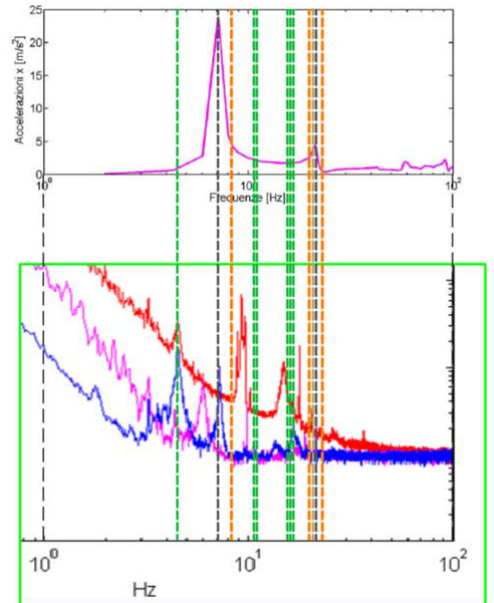
Figures 17. Amplification function comparison for longitudinal and transversal direction-central